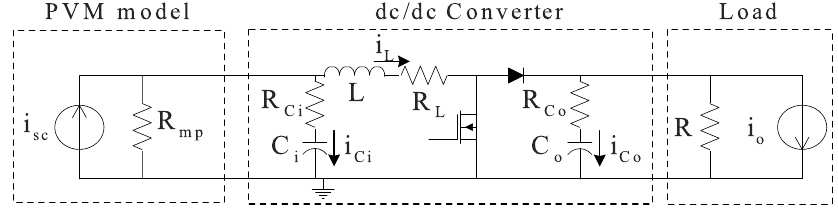
Figure 13. Model considering parasitic losses with Norton-based